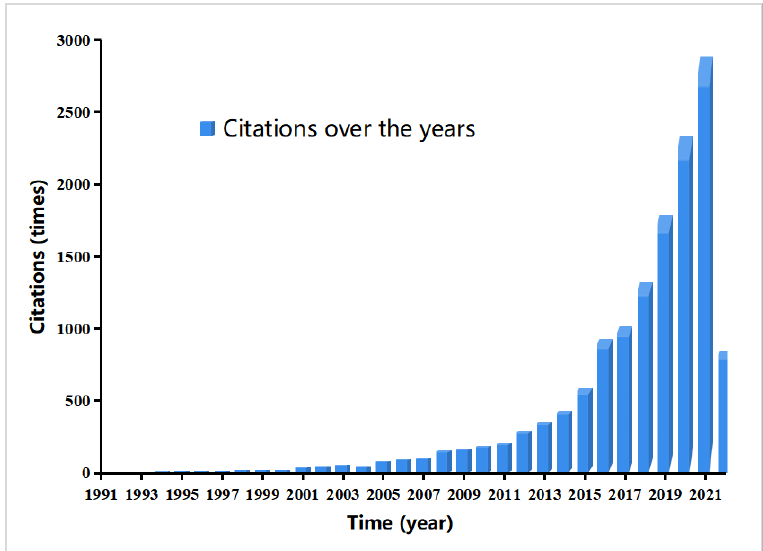
Figure 8. The changing trend of literature citations. Table 3. Analysis of highly cited papers (top